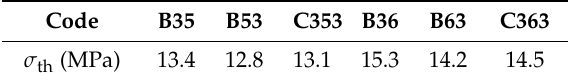
Table 4. Calculated creep threshold stress ( σ th ) during heat